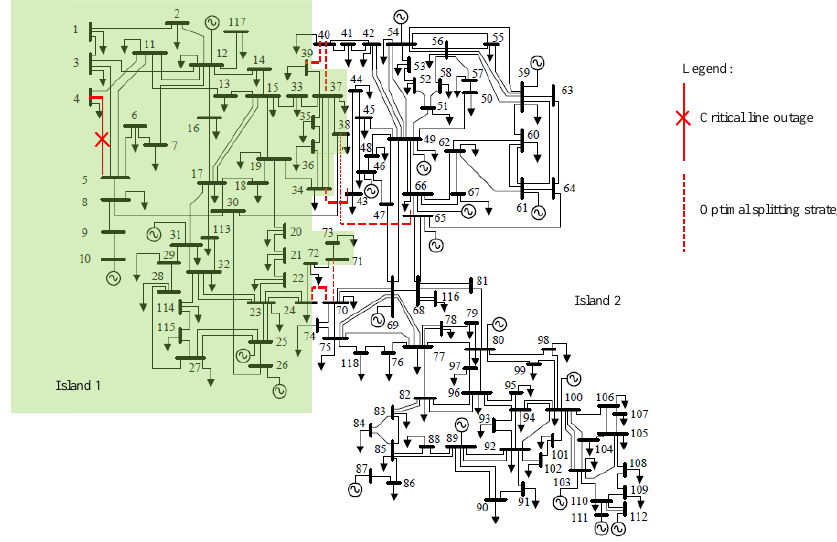
Figure 7. Optimal network splitting solution (dashed red lines) for the IEEE 118 bus system—Case A.